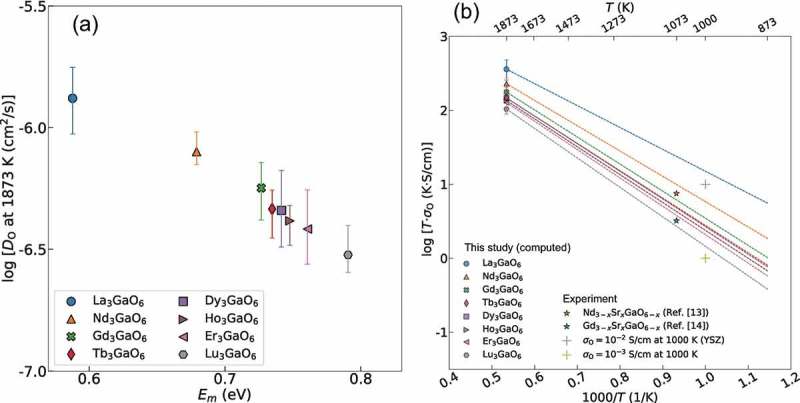
(a) Relationship between D
O obtained by FPMD at 1873 K and the lowest Em obtained by CI-NEB, and (b) predicted σ
O as a function of T based on D
O at 1873 K for eight Ln3GaO6 (Ln = La, Nd, Gd, Tb, Ho, Dy, Er, or Lu). Solid symbols denote computed or experimentally measured values from references. Dashed lines denote predicted values. The concentration of V
O
2+ of our computation is ~2.1% from the computational cell of Ln24Ga8O47. The concentration of V
O
2+ of Nd2.955Sr0.045GaO5.9775 [13] and Gd2.9Sr0.1GaO5.95 [14] are ~0.4 and ~0.8%, respectively. σ
O of 10−2 S/cm at 1000 K is described to show a reference level of YSZ [2]. The D
O values are averaged from three FPMD trials and error ranges are described between the minimum and maximum values.